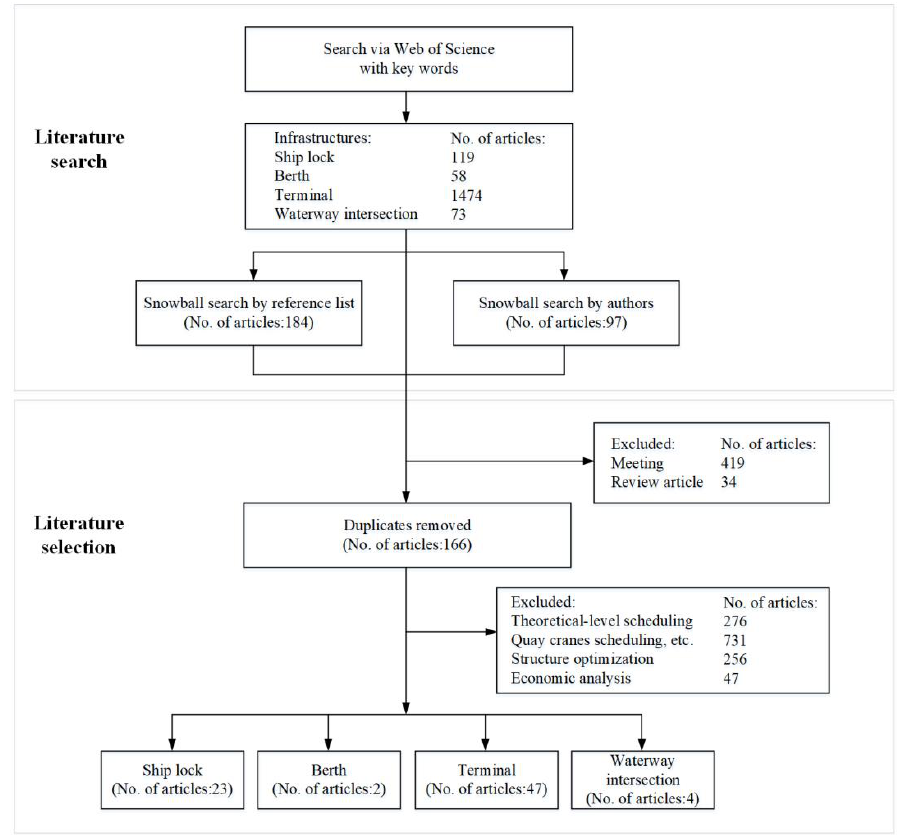
Figure 1. Steps of the literature search and collection.